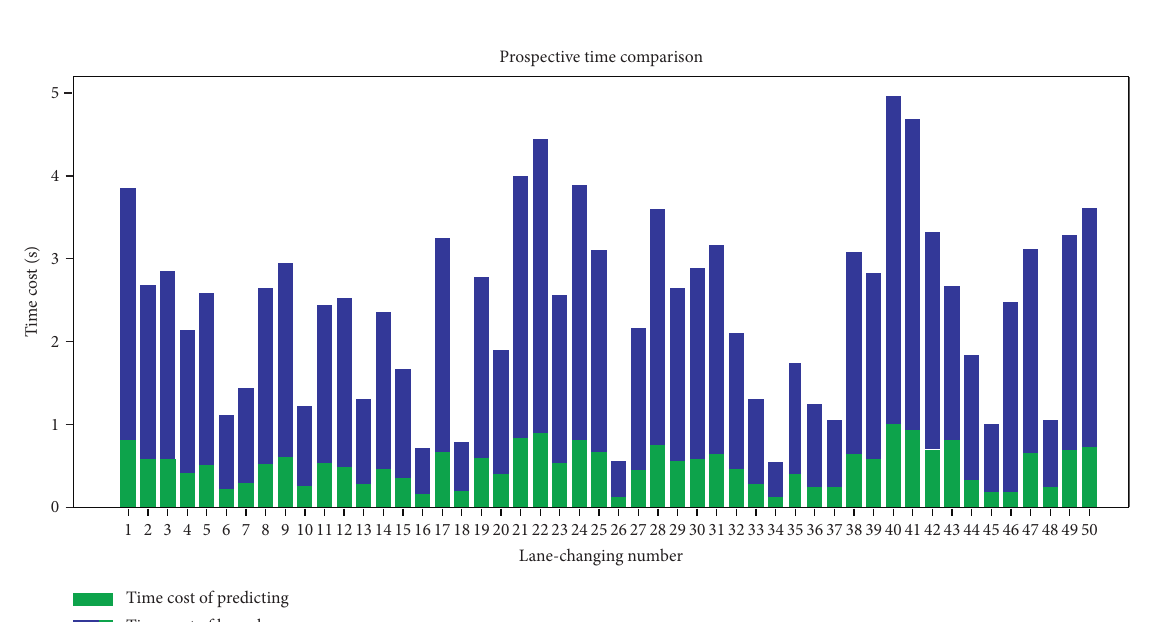
Figure 17: The time cost for different numbers of lane changes in testing.